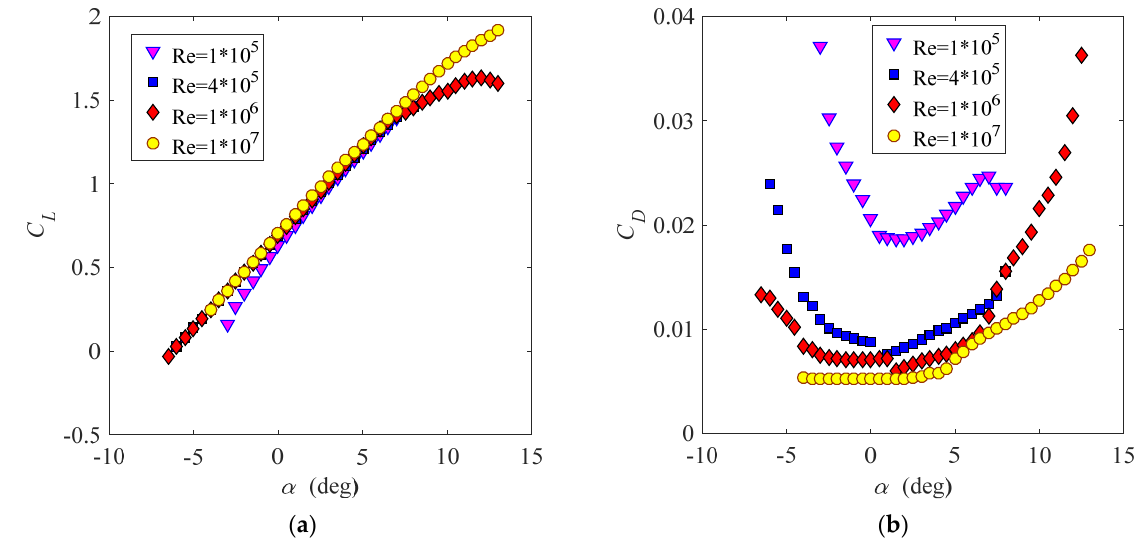
Figure 6. Variations of ( a ) C L and ( b ) C D with α of NACA6409 at different Reynolds numbers.